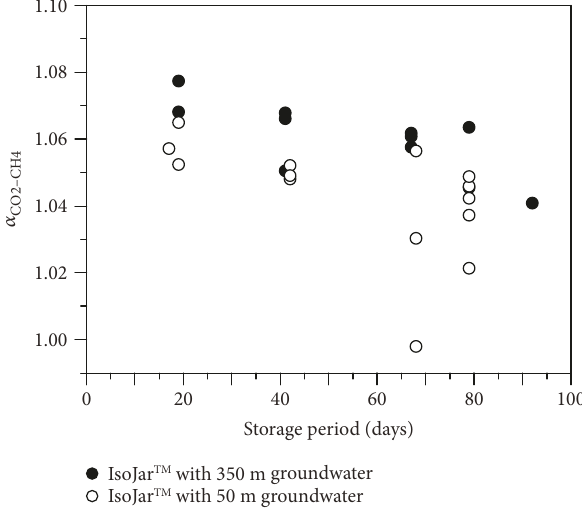
Figure 5: Temporal variations in the apparent carbon isotopic fractionation factor, α , between CO